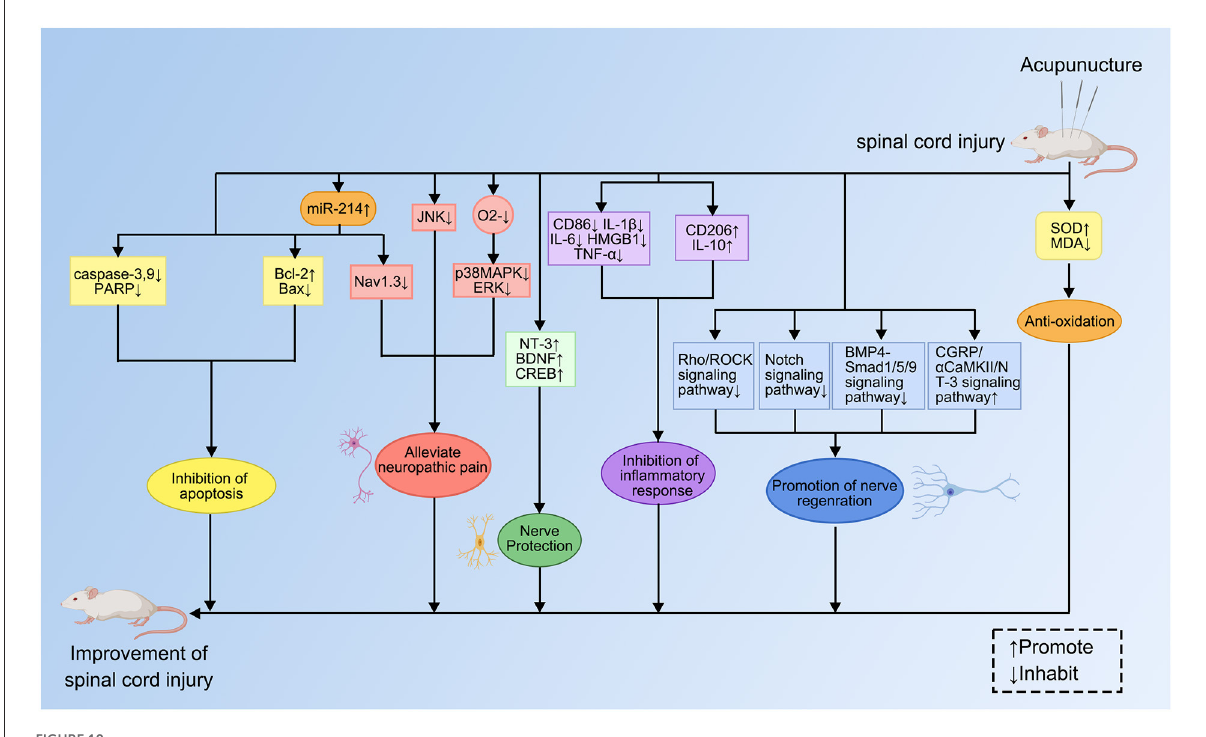
FIGURE10 Specific mechanisms of acupuncture for